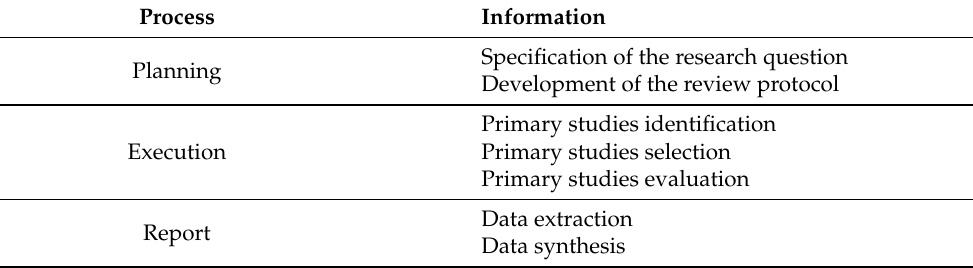
Table 1. The SLR processes.